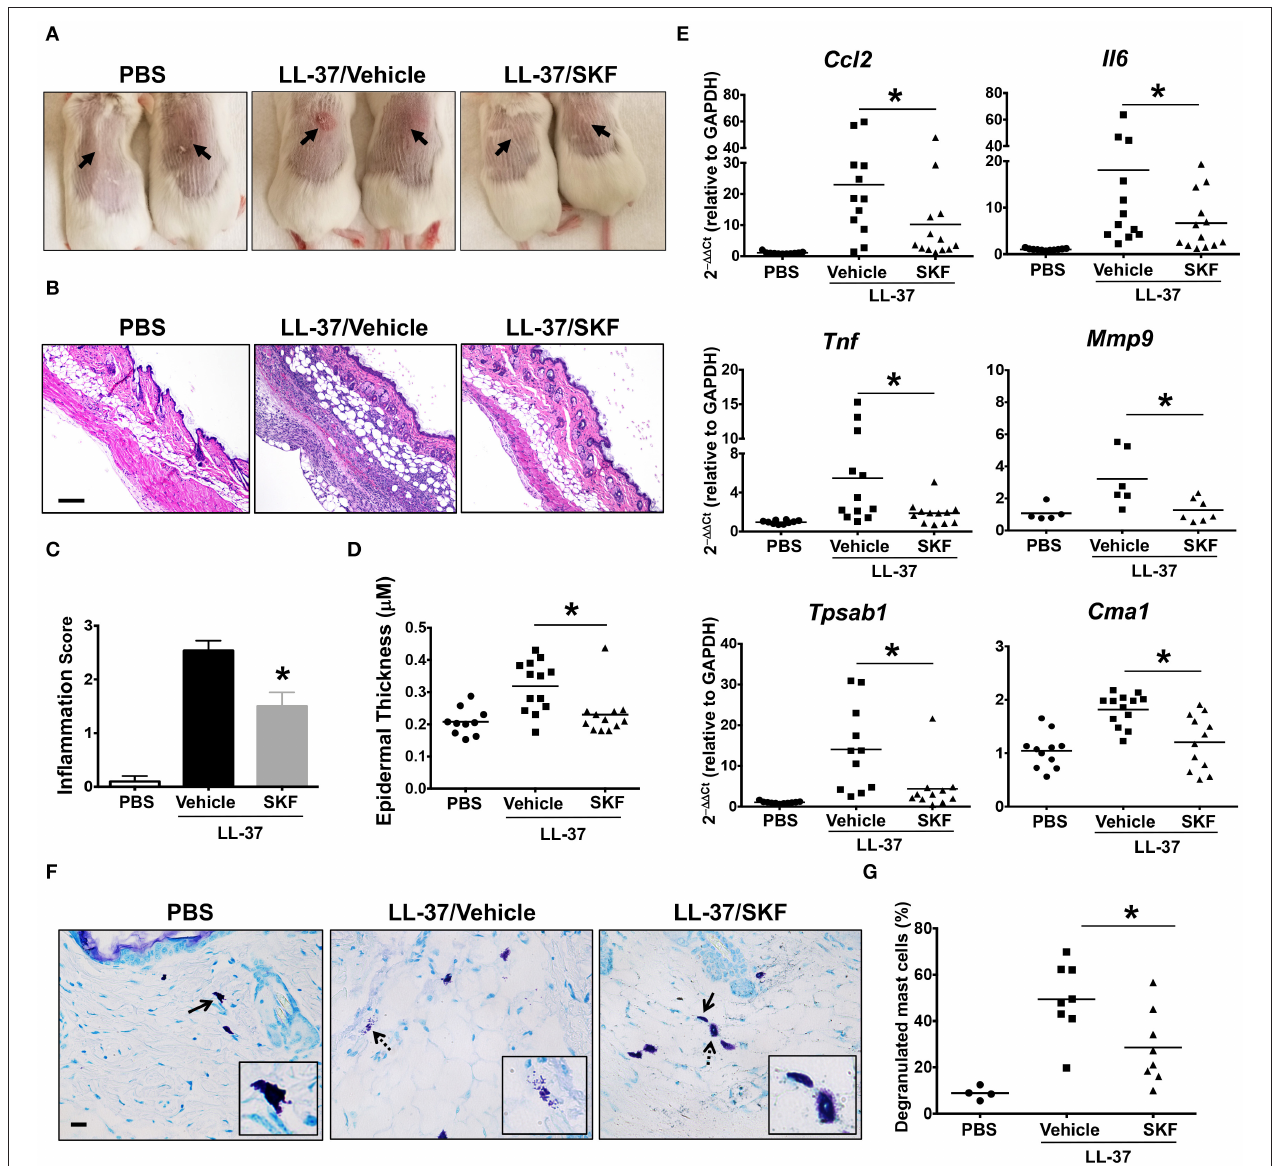
FIGURE 8 | SOCE inhibition prevents the development of LL-37-induced rosacea in mice. PBS (LL-37/Vehicle) or SKF treated (LL-37/SKF) BALB/c mice were injected with LL-37 into the dorsal skin (arrows) twice daily for two consecutive days. Mice that only received PBS on the dorsal skin were used as control. Representative pictures of (A) the dorsal skin and (B) H&E stained skin sections of mice from different cohorts are shown. Scale bar = 100 µ m. (C,D) Graphs represent inflammation scores and epidermal thickness of the H&E stained skin sections. (E) Relative gene expression of selected gene targets from the excised skin was analyzed by real-time PCR. Values are plotted as 2 − 11 Ct normalized to GAPDH levels. (F) Mice were treated with vehicle or SKF and exposed to a single dose of LL-37 in their hind skin. After 30min of LL-37 injection, the skin tissues were harvested and paraffin embedded skin sections were stained with toludine blue. Representative pictures of the skin sections are shown. Bold arrows indicate intact mast cells whereas dotted arrows represent degranulated mast cells. The inset figure is an enlarged image of the cell(s) shown by the arrows. Scale bar = 50 µ m. (G) Graph shows the percentage of degranulated mast cells in the skin tissue of different cohorts of mice. Data are mean ± S.E. from three to five experiments ( n = 4–12 mice/group) Statistical significance was determined by Student’s t -test. * p <